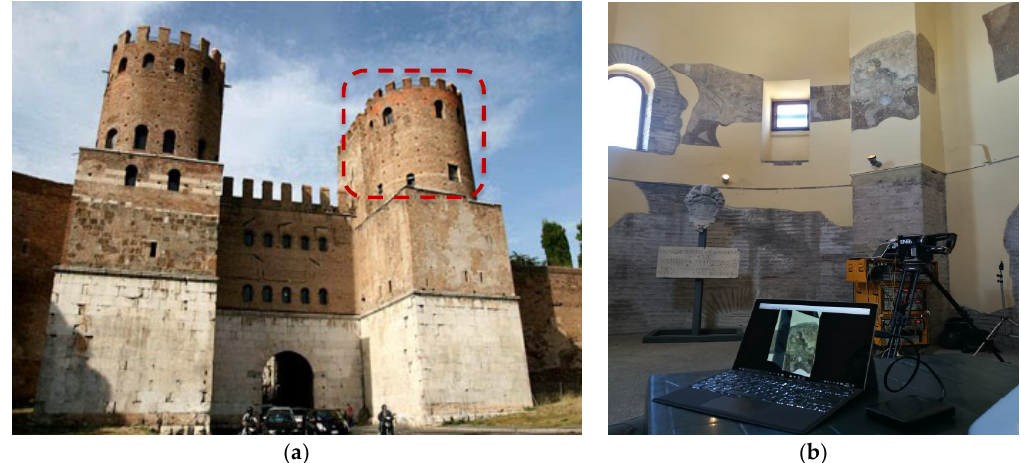
Figure 6. ( a ) Saint Sebastian monumental gate, which is part of the Aurelian Wall and the location of the Walls Museum in Rome (Italy). The red dashed square indicates the digitalized tower room; ( b ) detail of the interiors of the right tower with the RGB-ITR in working position. (Photo: S. Ceccarelli).